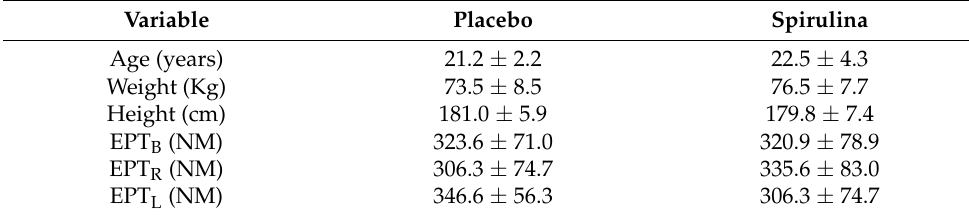
Table 1. Personal characteristics of the